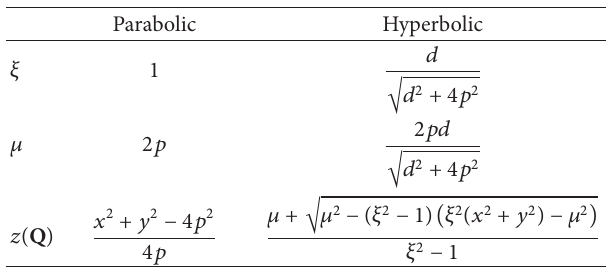
Table 1: The parameters of